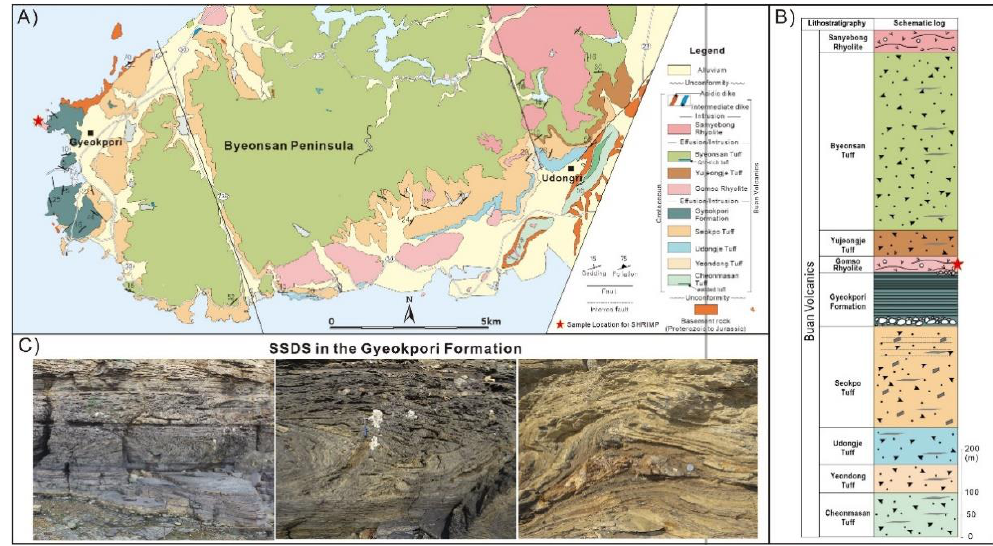
Figure 3. ( A ) Geological map of the Buan Volcanics (modified after [28]), ( B ) Schematic log of the volcano-sedimentary succession in the Buan Volcanics (modified after [13]), ( C ) Outcrop photographs of soft sediment deformation structures (SSDS) in the Gyeokpori Formation.